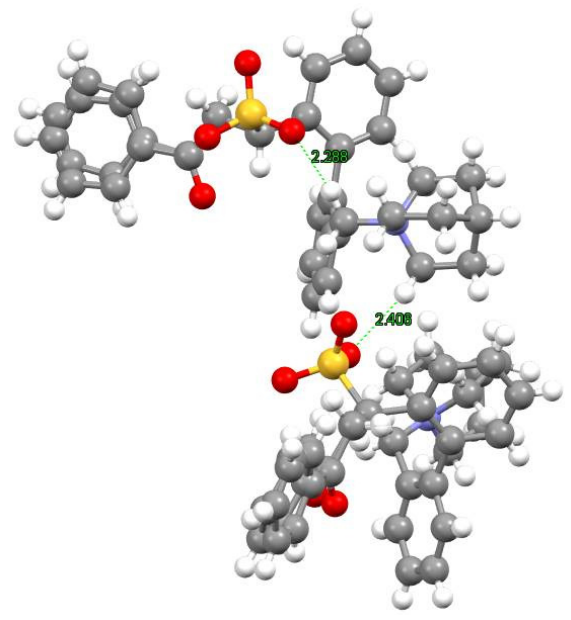
Figure 4. X-ray crystal structure of compound 1a .